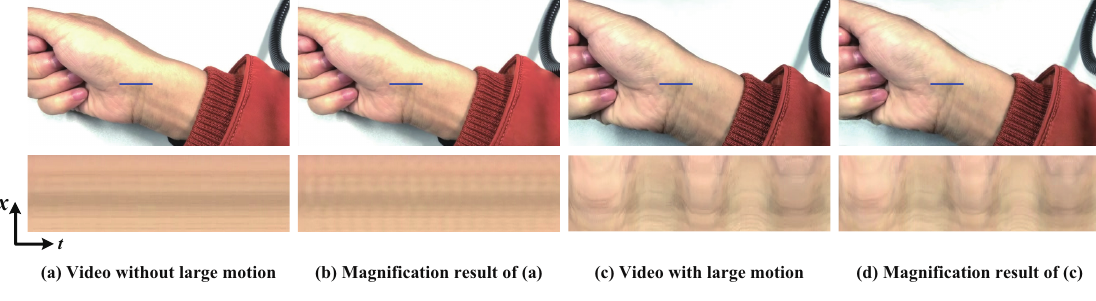
Figure 11. Failure case: ( a ) Input sequence without large motion. The subtle motions of blood vessels are magnified by our algorithm, as shown in ( b ). The motion of the pulsing arteries can be visible when observing a spatio-temporal X − T slice. ( c ) Input video in presence of large motion. The motion of the pulsing arteries can barely be seen in the magnification result, as shown in ( d